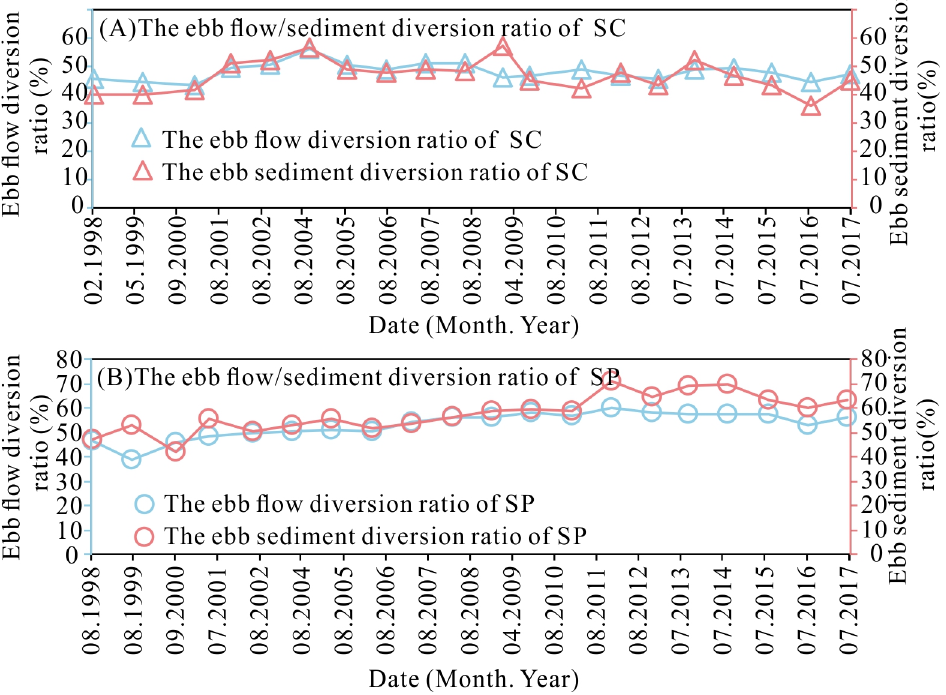
Figure 10. ( A ) Ebb flow/sediment diversion ratio of the SC during 1998–2017. ( B ) Ebb flow/sediment diversion ratio of the SP during 1998–2017. (Note: The data about the ebb flow/sediment diversion ratio of the SP during 1998–2017 were collected by the Changjiang Estuary Waterway Administra- tion Bureau